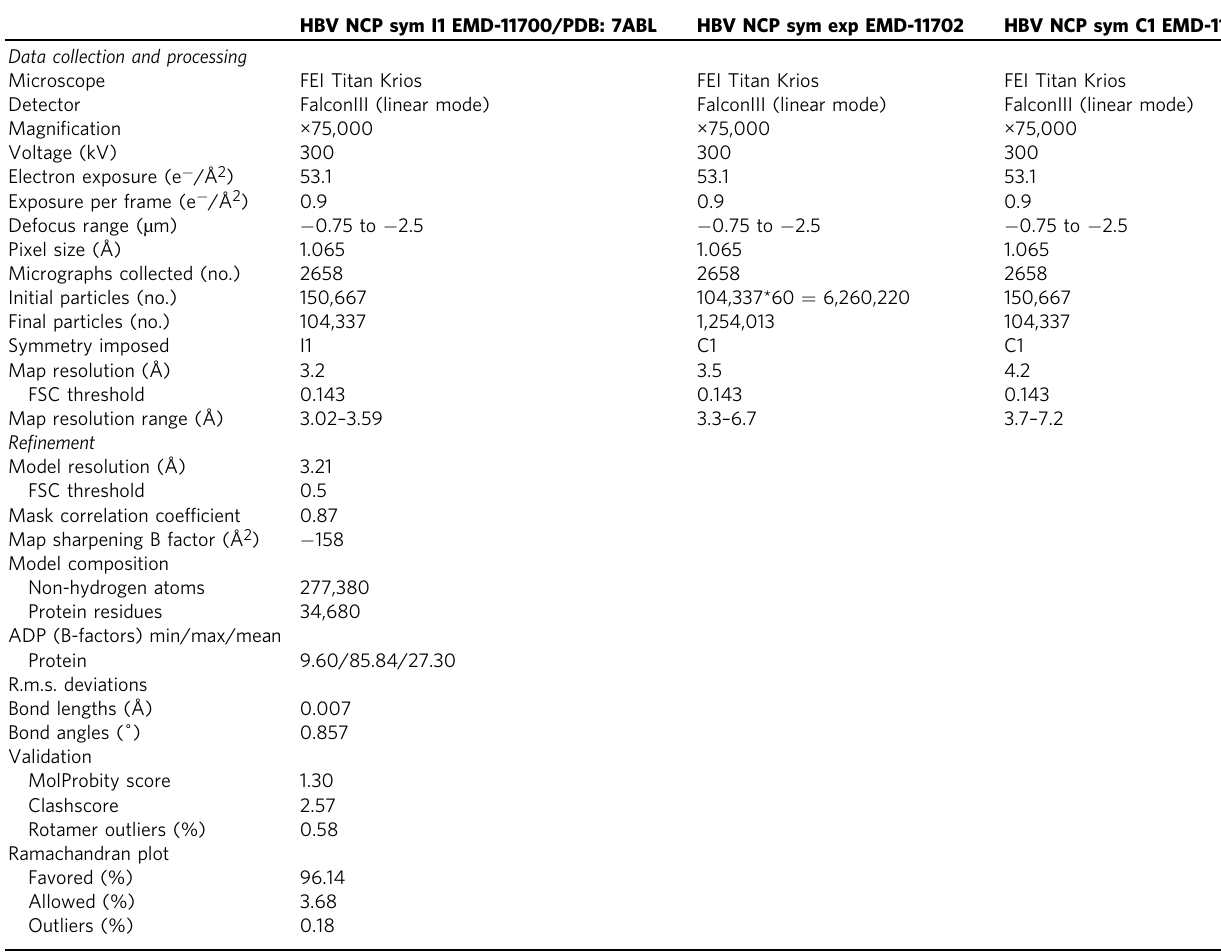
Table 2 Data for Cryo-EM